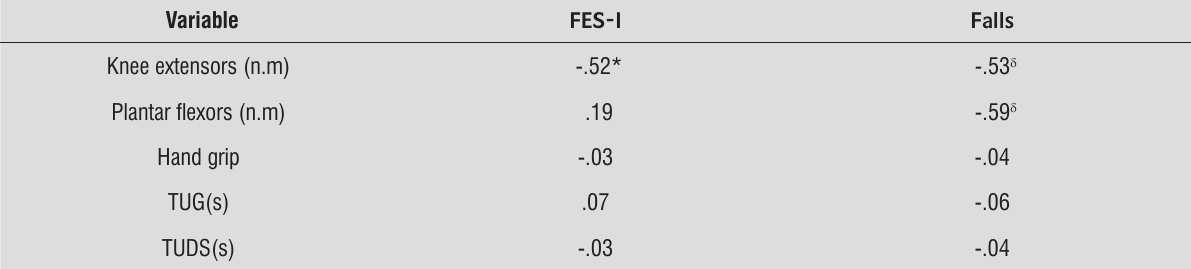
Table 3 - Associations between the concern with the fear of falling, falls and other variables (Pearson’s